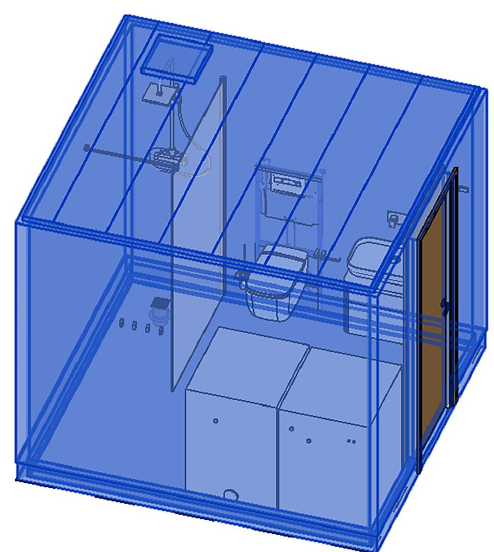
Figure 5. Prefabricated bathroom BIM object (BIMobject, 2022b)